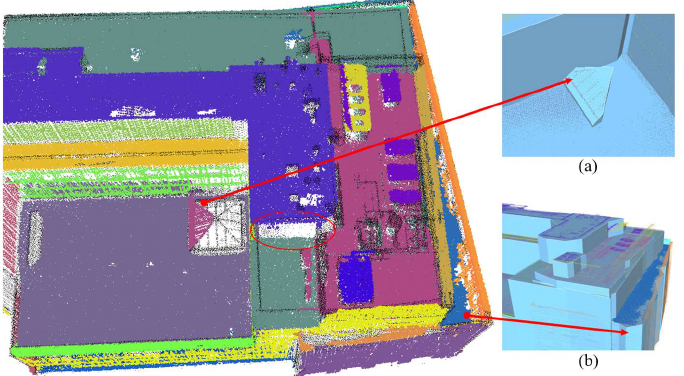
Figure 1. Examples of complex building structures and incomplete planar primitives. Colors are randomly set for different planes and the black dots denote unsegmented points. Points of the façade inside the red oval are missing. ( a ) Planar segments are lost due to the partial sparsity. ( b ) Without the constraint of the façade, the outward boundaries are inaccurate by rooftop modeling.